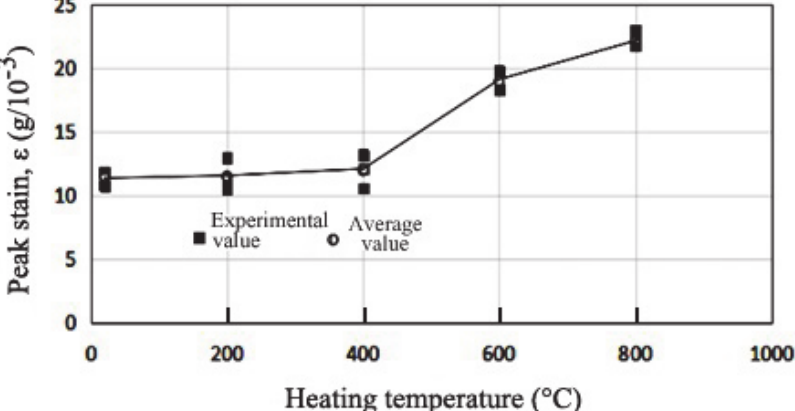
Figure 8: The relationship between peak strain and heating temperature.